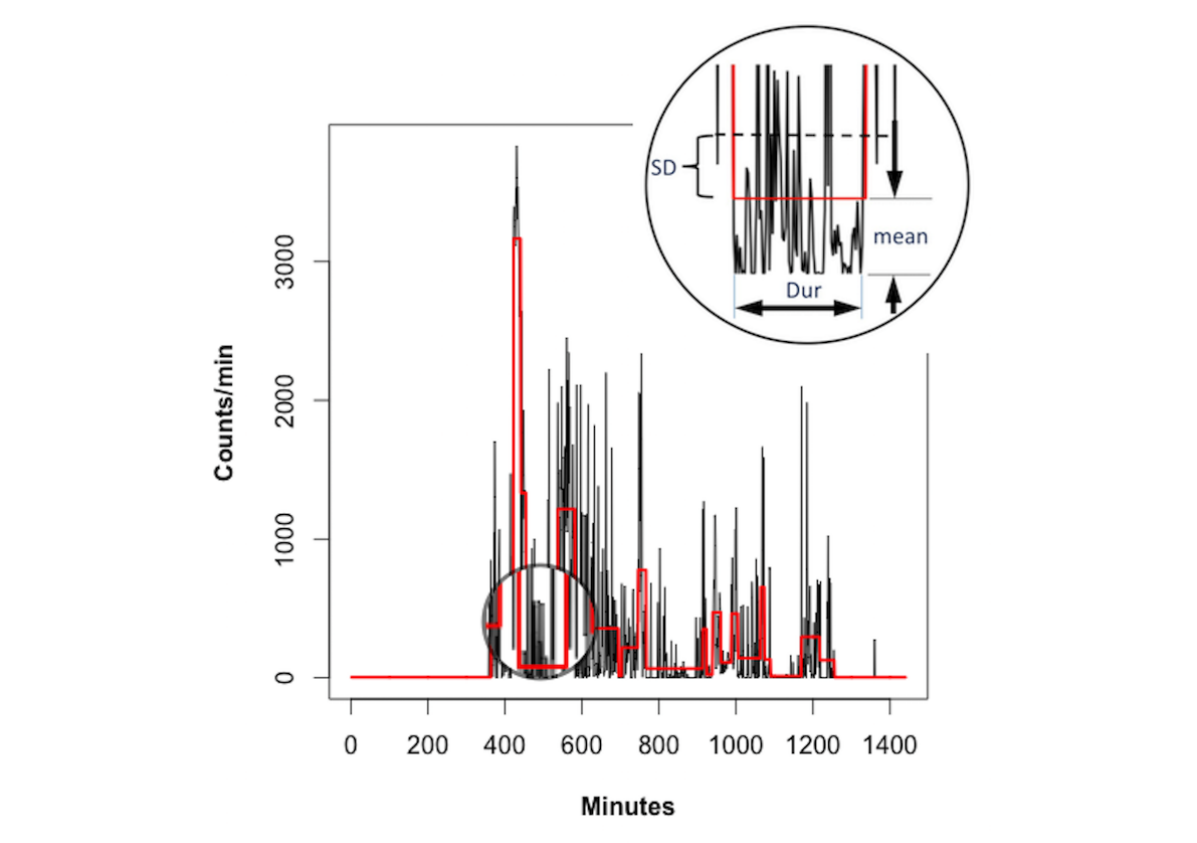
Figure 2. Segmentation of counts-per-minute sequences. Dur: